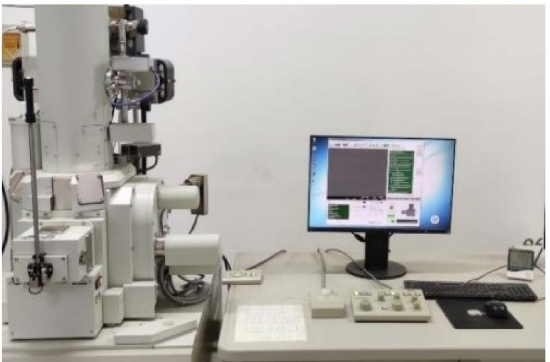
Figure 2. A JSM-7500F SEM.